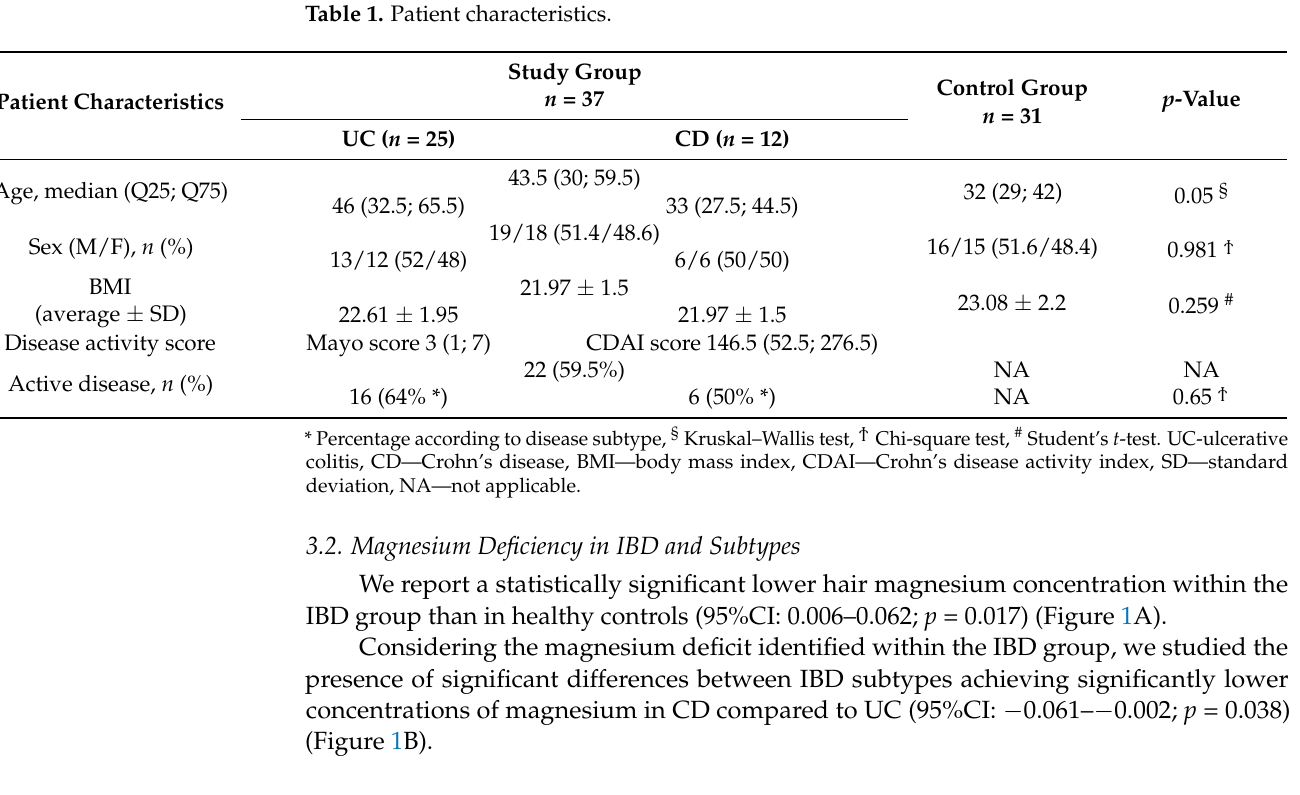
Table 1. Patient characteristics.